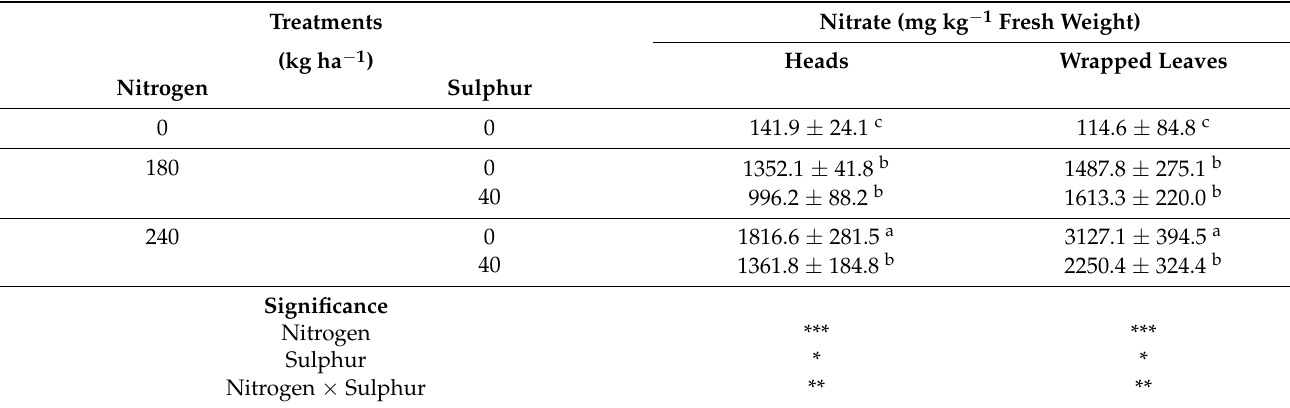
Data are the means ± standard error ( n = 4). Different superscript letters indicate significant differences between fertilisation treatments ( p < 0.01; Duncan’s test). * p < 0.05; ** p < 0.01; *** p < 0.001; ns, not significant (ANOVA), for interactions with and between nitrogen and sulphur